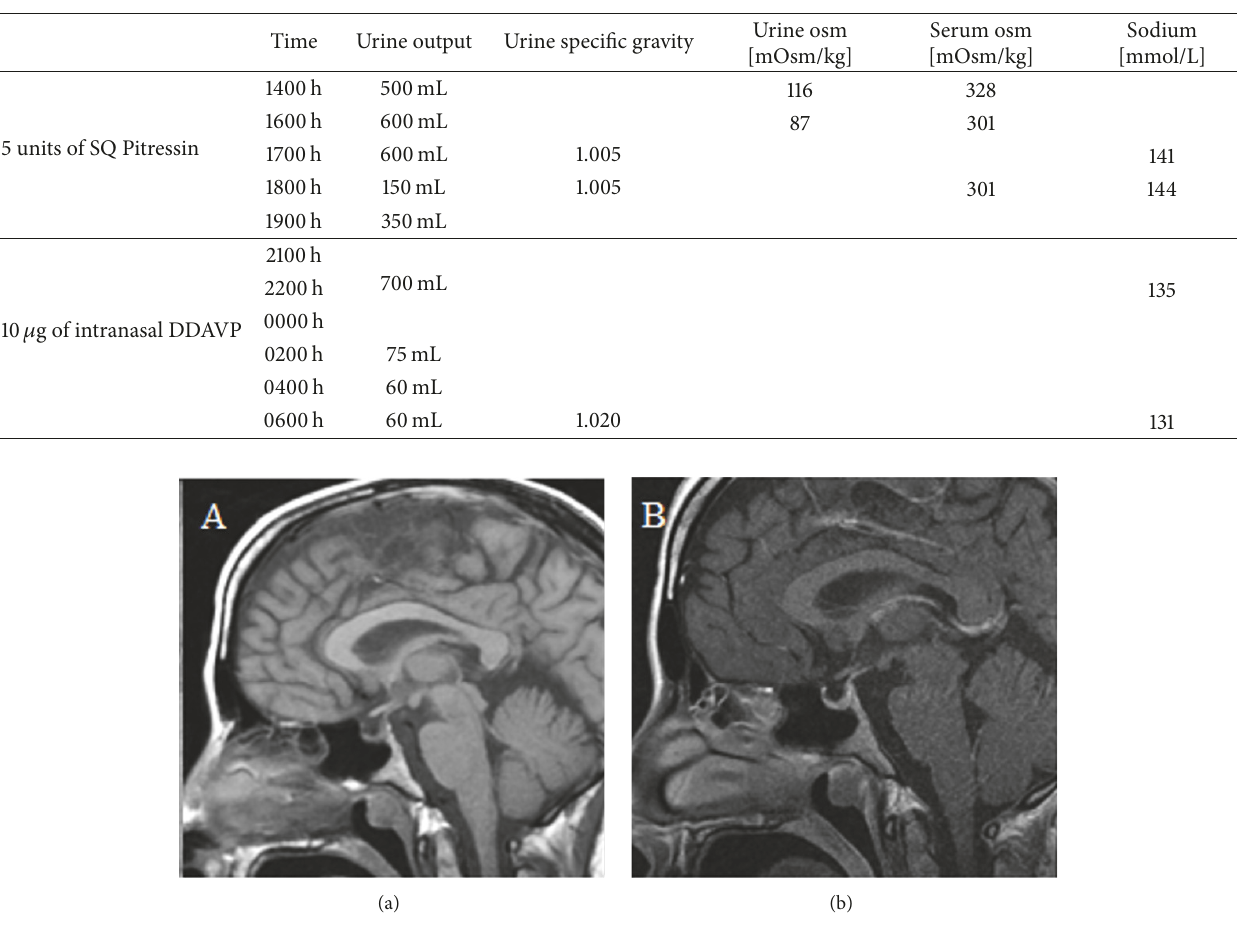
Figure 2: (a, b) Pre- and postcontrast brain MRI images of case 2 show that posterior pituitary bright spot is not visualized and that the anterior pituitary appears small for age and postpartum